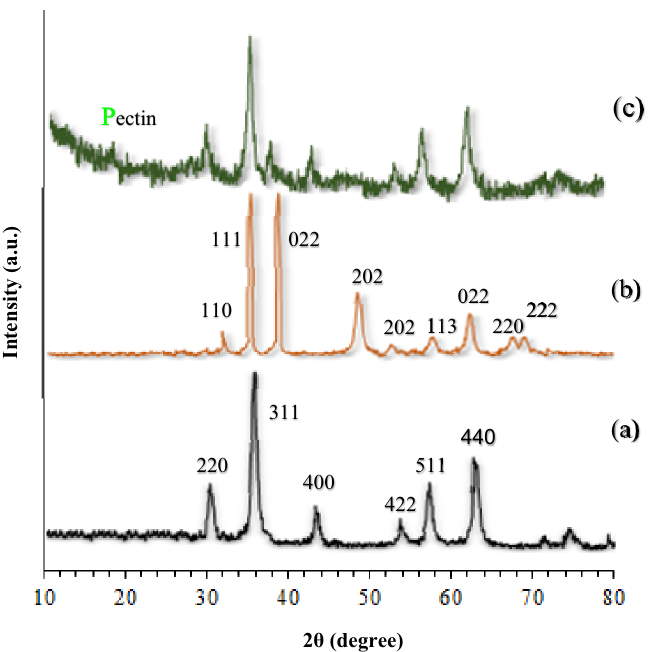
Figure 7. XRD of ( a ) Fe 3 O 4 , ( b ) CuO, ( c ) Fe 3 O 4 @Pectin@(CH 2 ) 3